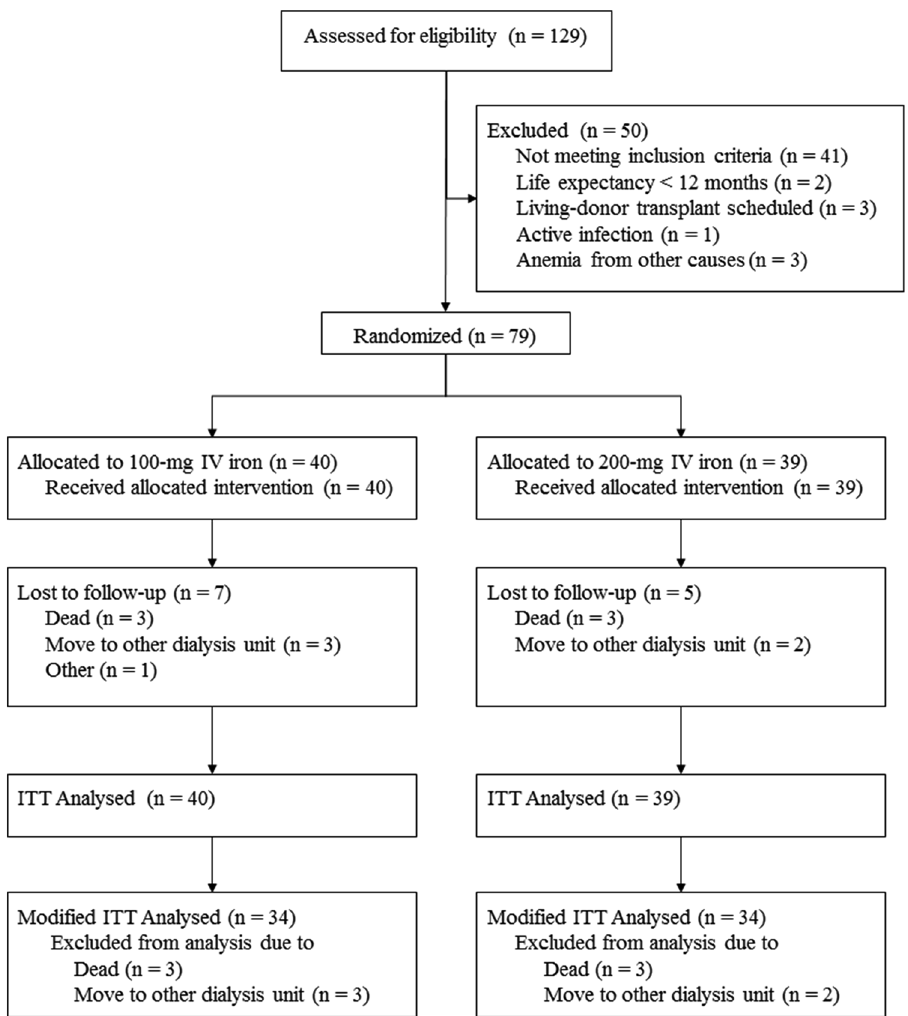
Figure 1. Trial profiles (CONSORT